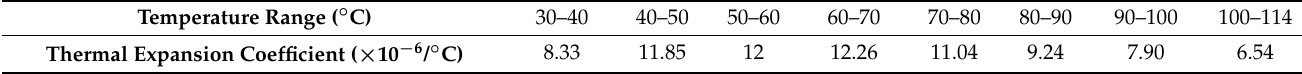
Figure 1. Specific heat capacity and thermal expansion rate of the brake shoe. ( a ) Specific heat capacity ( b ) Thermal expansion rate. Table 1. Thermal expansion coefficient of the brake